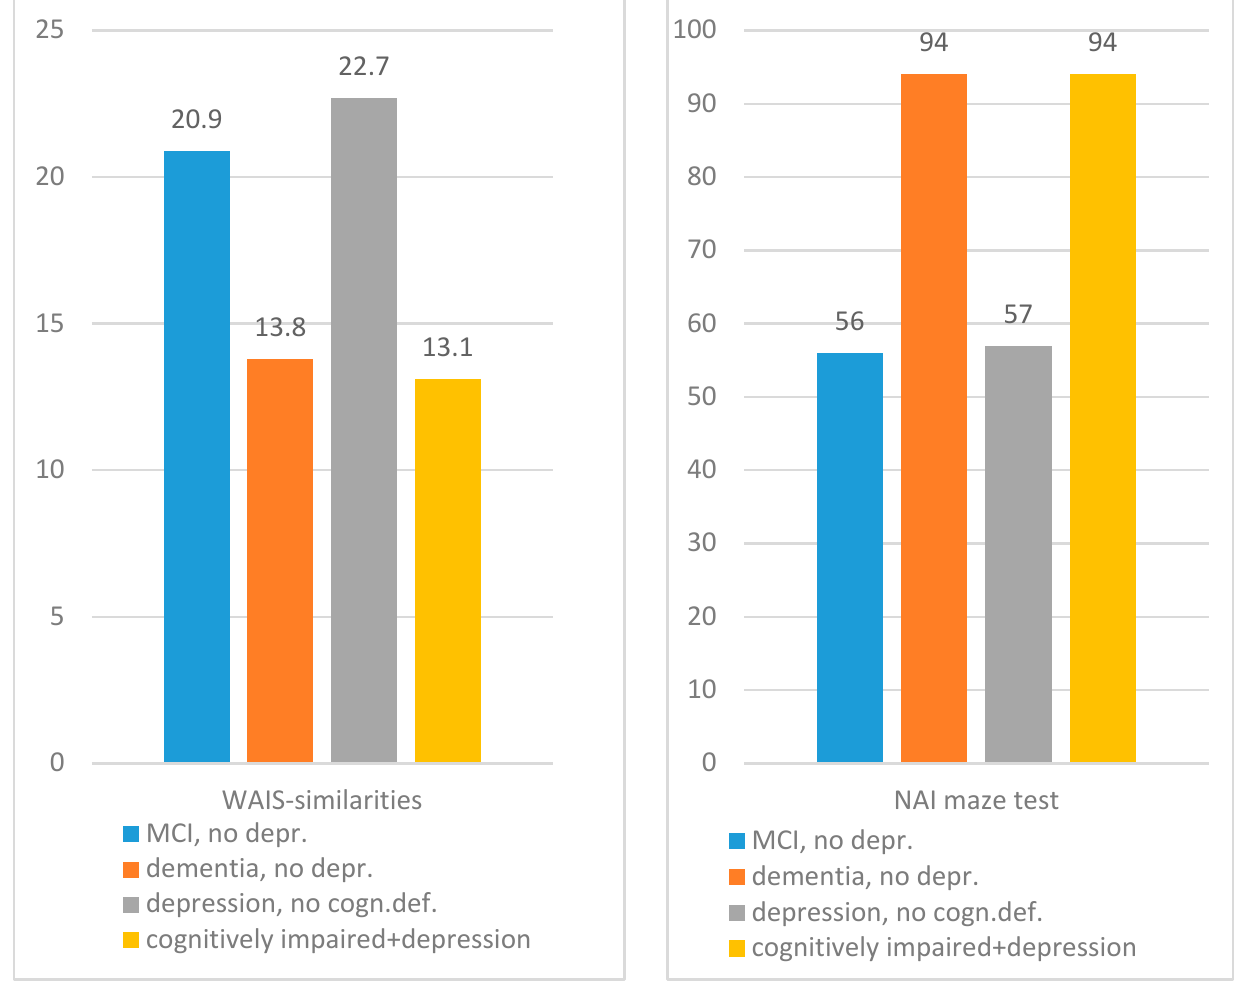
Figure 2. WAIS similarities and NAI maze test: diagnosis groups. Posthoc, a one-way ANOVA with Bonferroni correction (for variance homogeneity) or Games–Howell (for variance inhomogeneity) was performed for each dependent variable (detailed statistical values can be found in the supplement).